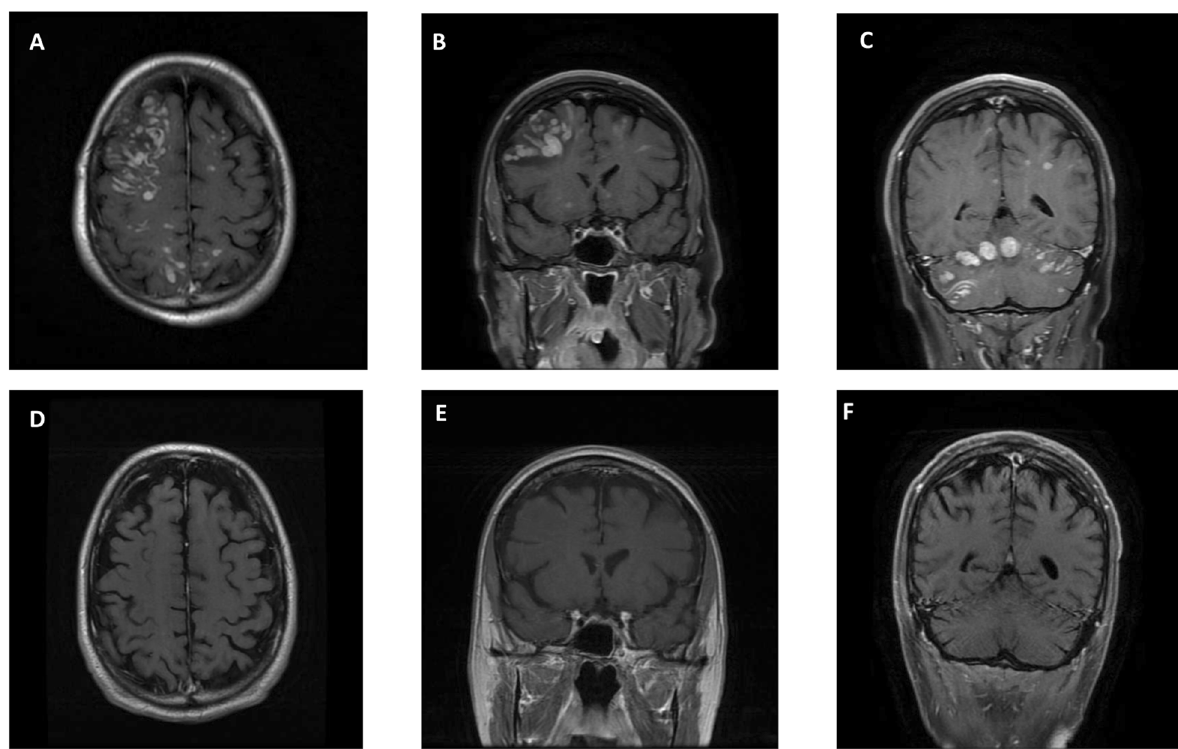
Fig. 2 MRI Brain before and after Loralatinib treatment. A , B , C MRI of the brain before starting Lorlatinib (pre-treatment) showing innumerable diffuse enhancing lesions with surrounding vasogenic edema, with a right frontal lobe and bilateral cerebellar predominance. D , E , F Treatment response to lorlatinib with markedly decrease in size and number of brain metastasis and markedly improved cerebral